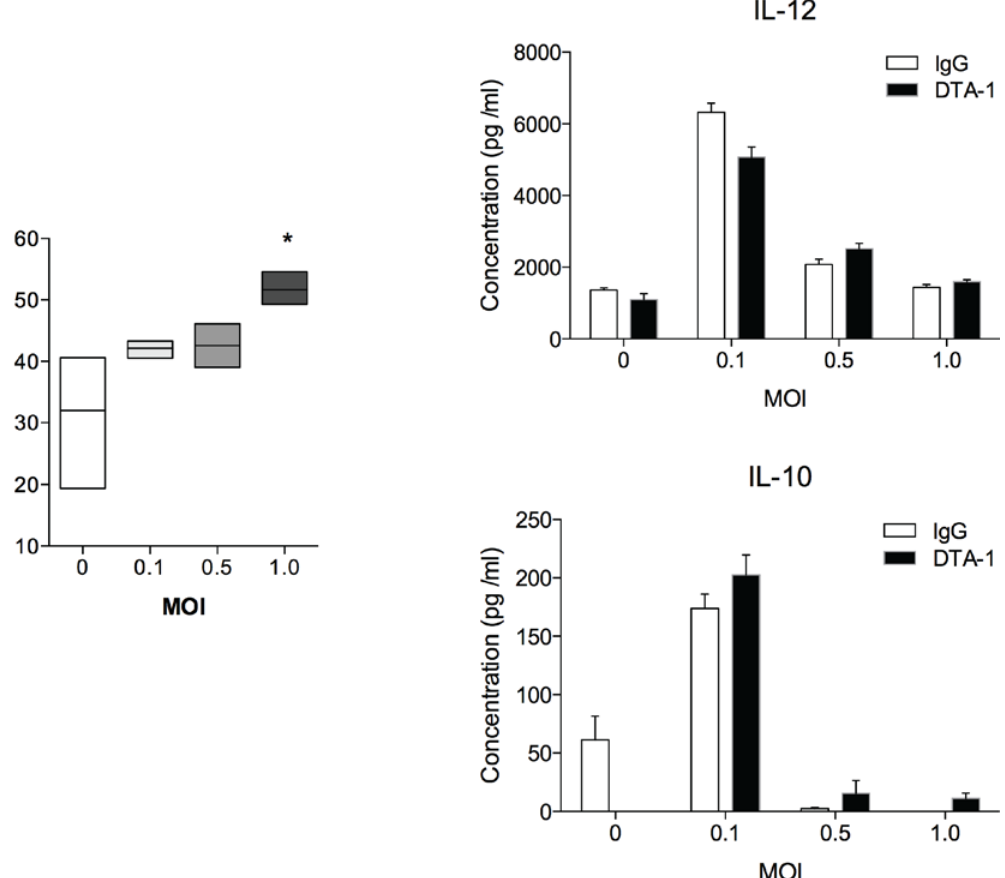
Fig 5. GITR activation does not affect cytokine production by macrophages. Immortalized bone marrow derived macrophages (iBMDM) were plated (2x10 5 /well) and stimulated or not with DTA-1 (anti-GITR antibody, 100 μ g/ml) or Rat serum (irrelevant antibody, 100 μ g/ml) and infected with different rates of tachyzoites of the ME-49 strain of T . gondii tachyzoites, for eighteen hours. The cells were washed and assessed for the expression of GITR by flow cytometry (A). Results were shown as the percentage of GITR + cells gated on CD11b + F4/80 + cells. Alternatively, the culture supernatant was collected and analyzed for IL-12p40 (B) and IL-10 (C) by ELISA. Error bars indicate mean +/- SD. * P < 0.05.